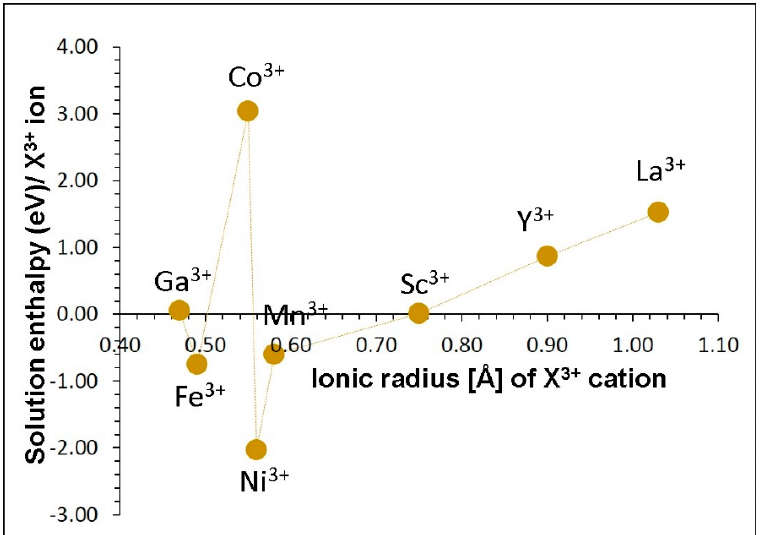
Figure 5. Solution enthalpies of X 2 O 3 (X = Ga, Fe, Co, Ni, Mn, Sc, Y and La) with respect to the X 3+ ionic radius in LiAlO 2 .